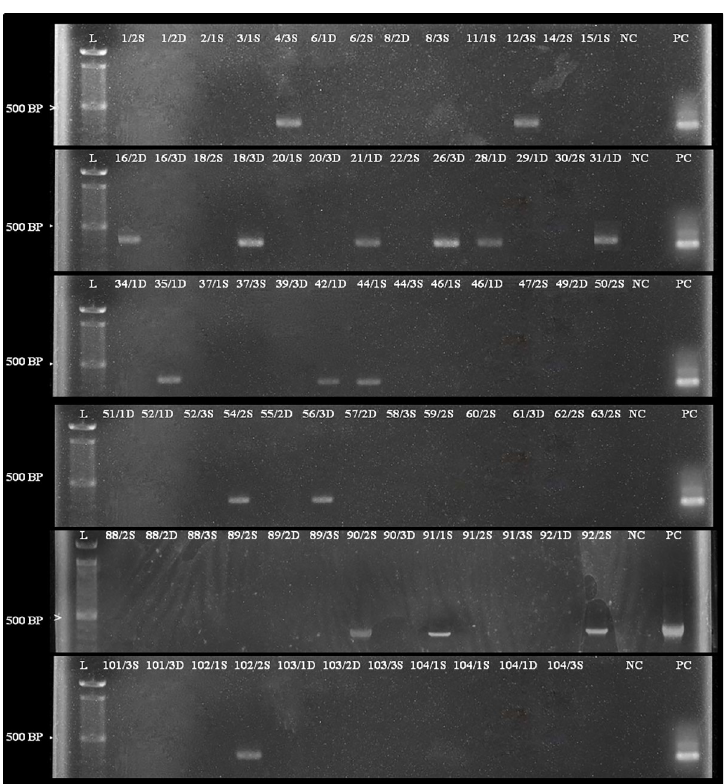
Fig 2. Amplified products of internal transcribed spacer (ITS) region for Neagleria species using genus-specific primer 1. L: 100 bp ladder; NC: Negative control; PC: Positive control; each sample is labelled by incorporating location, site, and depth of the collected sample. Among these samples 4/3S, 12/3S, 16/2D, 18/3D, 21/1D, 26/3D, 28/ 1D, 31/1D, 35/1D, 42/1D, 44/1S, 54/2S, 56/3D, 90/2S, 91/1S, 92/2S, and 102/1S show bands in the region of 500 bp.